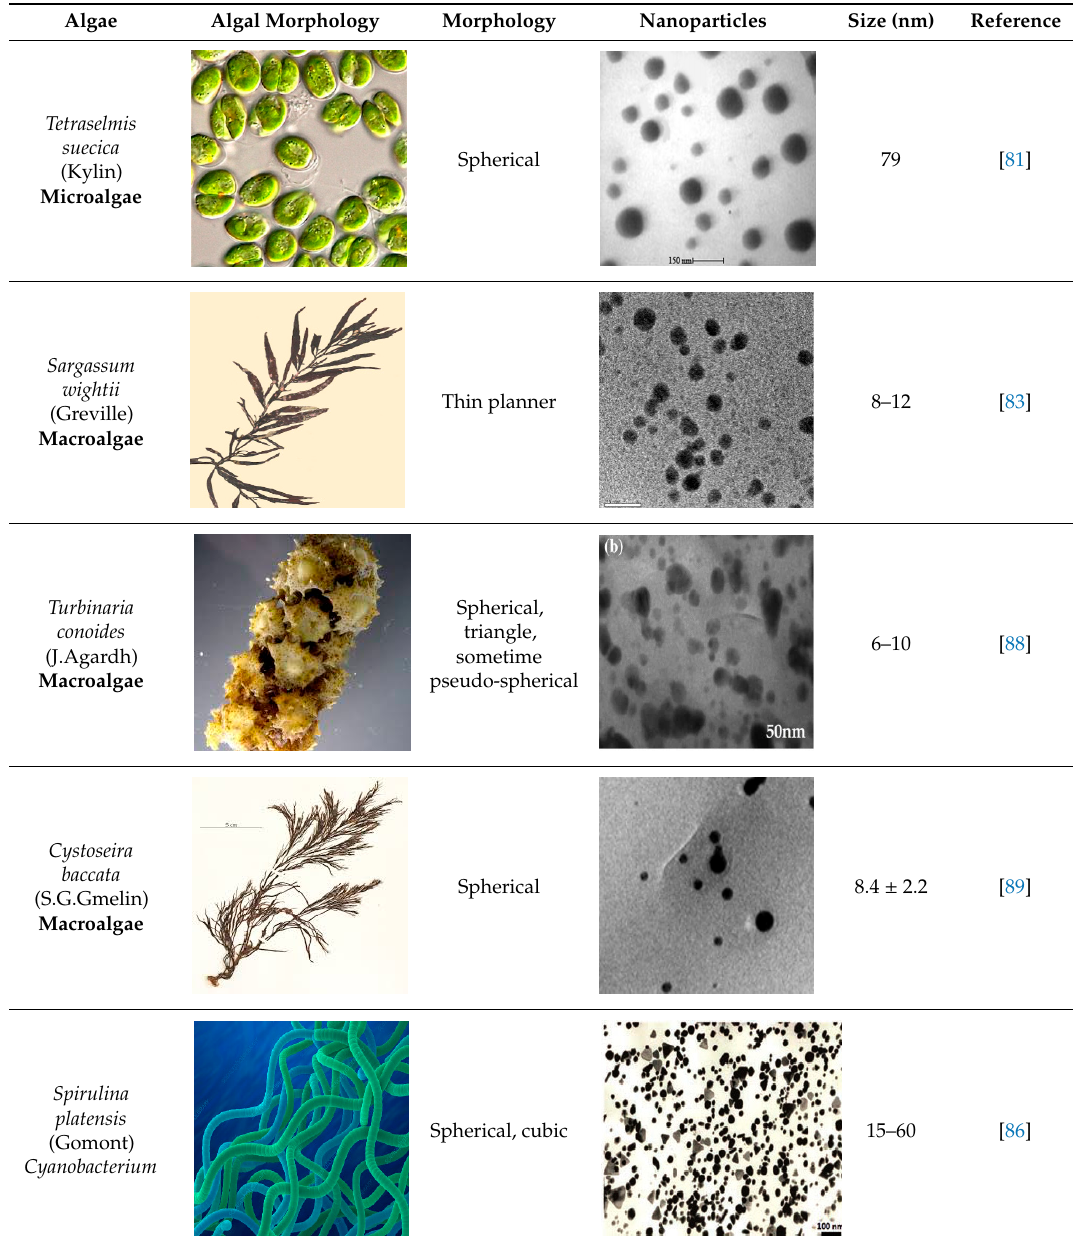
Table 2. Algal-mediated synthesis of gold nanoparticles (AuNPs). (Copyright permission has been granted for each figure).